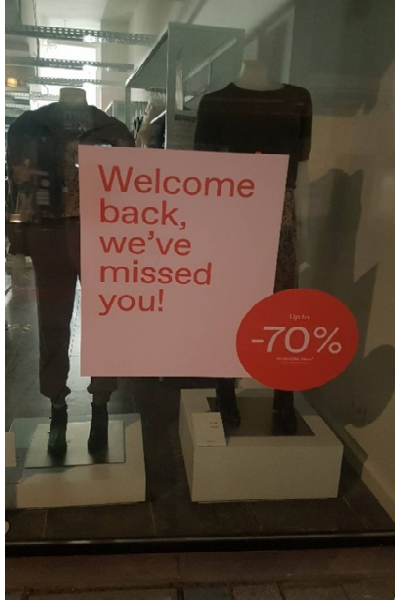
Figure 12. Welcome back, we’ve missed you!